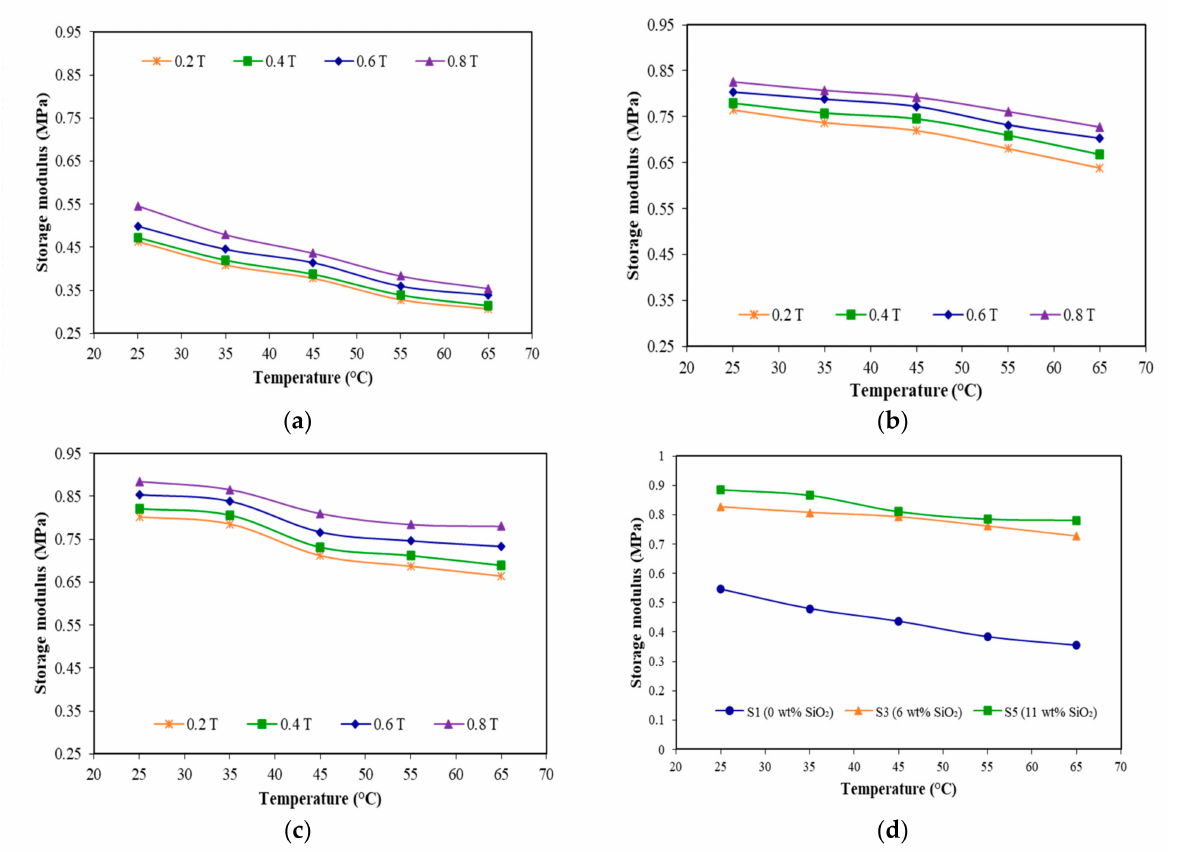
Figure 9. Storage modulus versus temperature at different magnetic fields and silica contents of ( a ) S1 (0 wt.% SiO 2 ), ( b ) S3 (6 wt.% SiO 2 ) and ( c ) S5 (11 wt.% SiO 2 ), and ( d ) comparison of storage modulus versus temperature for all samples at 0.8